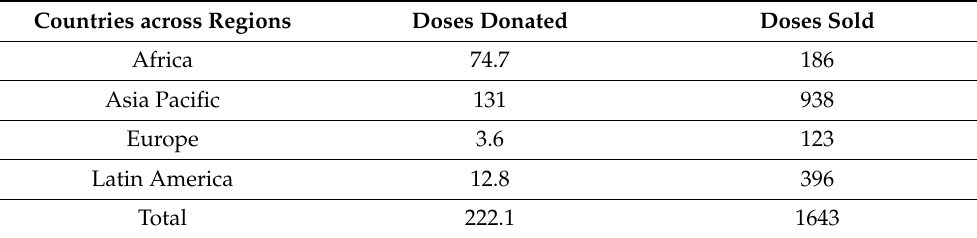
Table 1. Donated and sold Chinese vaccines by 16 May 2022 (unit: million). Countries across Regions Doses Donated Doses Sold Africa